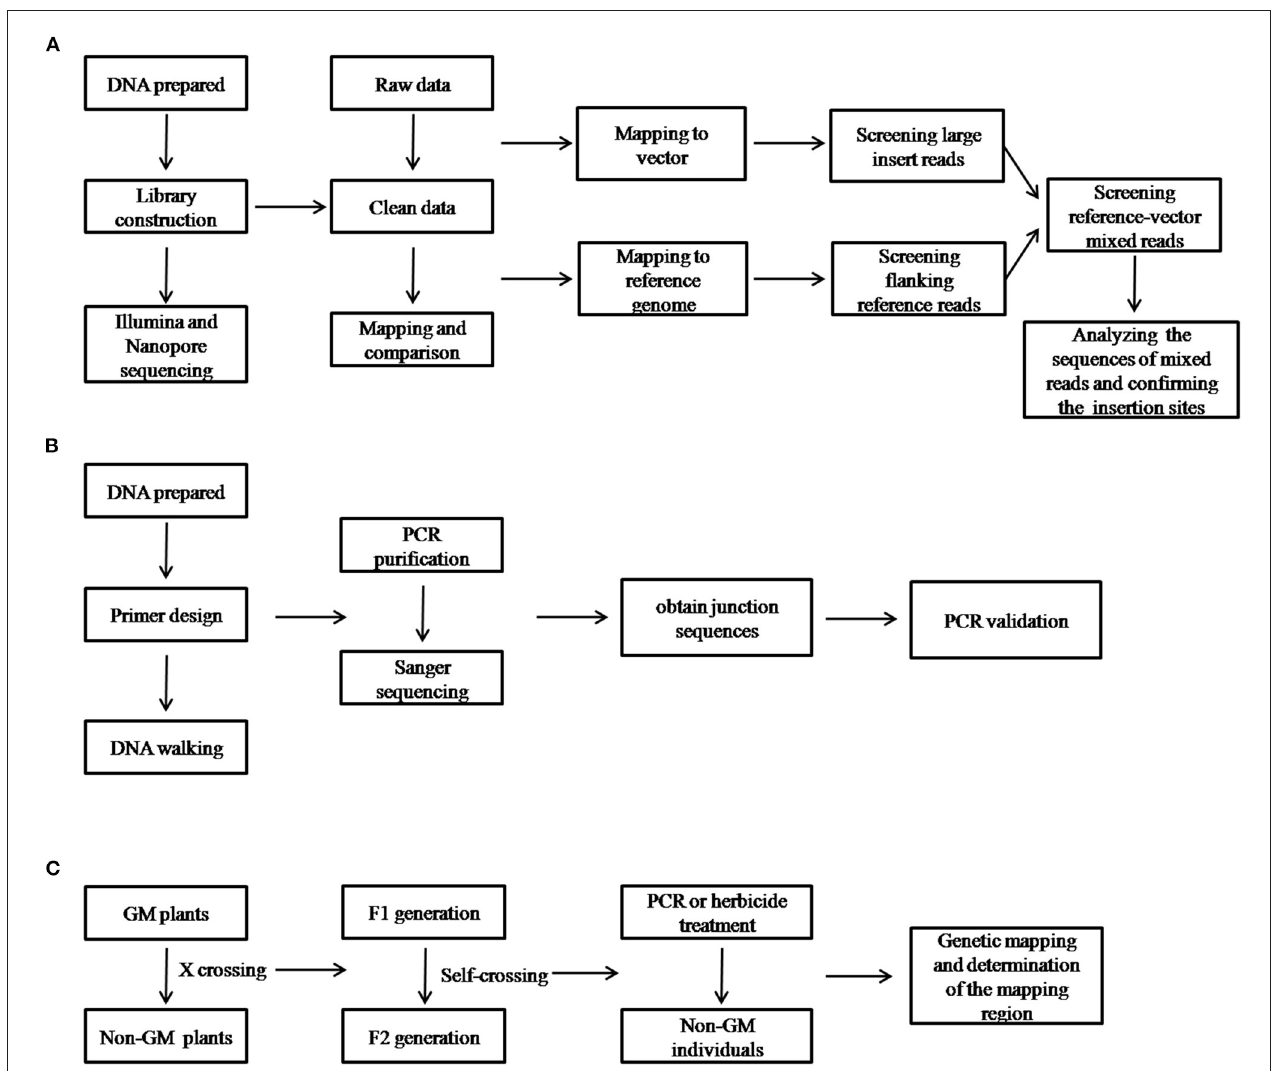
FIGURE 1 | Schematic diagram of the workflow for the identification of the insertion site and its validation using the different techniques implemented in this study. (A) Illumina and nanopore sequencing; (B) thermal asymmetric interlaced polymerase chain reaction (TAIL-PCR); and (C) genetic